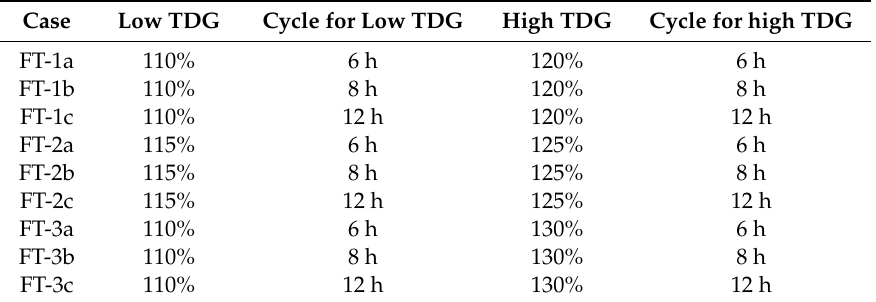
Table 1. Conditions of the fluctuant total dissolved gas (TDG) test. Cases with the same letter have the same cycle, and cases with the same number have the same TDG